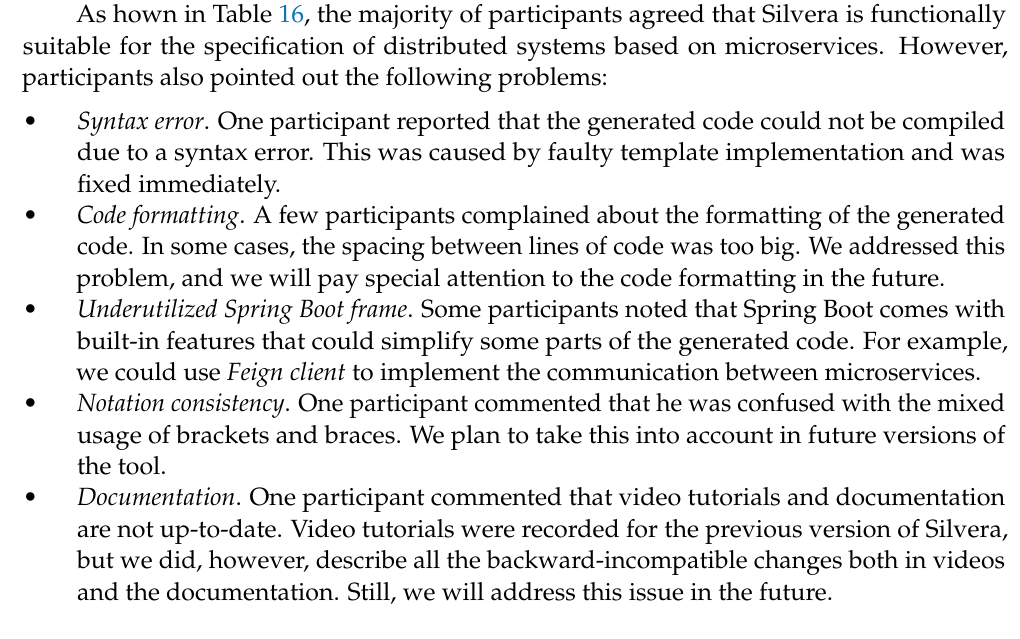
Table 16. Percentages of responses (n = 18) for Functional suitability , Usability , Reliability , Productivity , Extendability and Expressiveness groups of